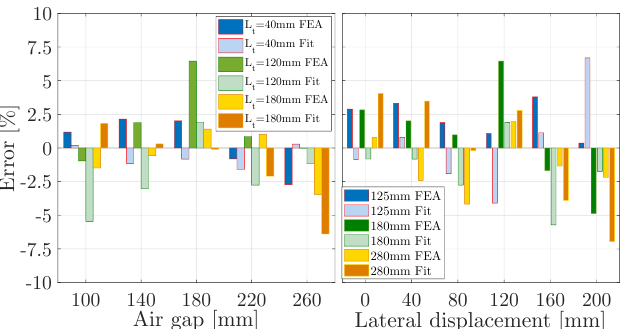
Figure 12. Errors between the experimental data and both FEA simulations and fitting ap- proach